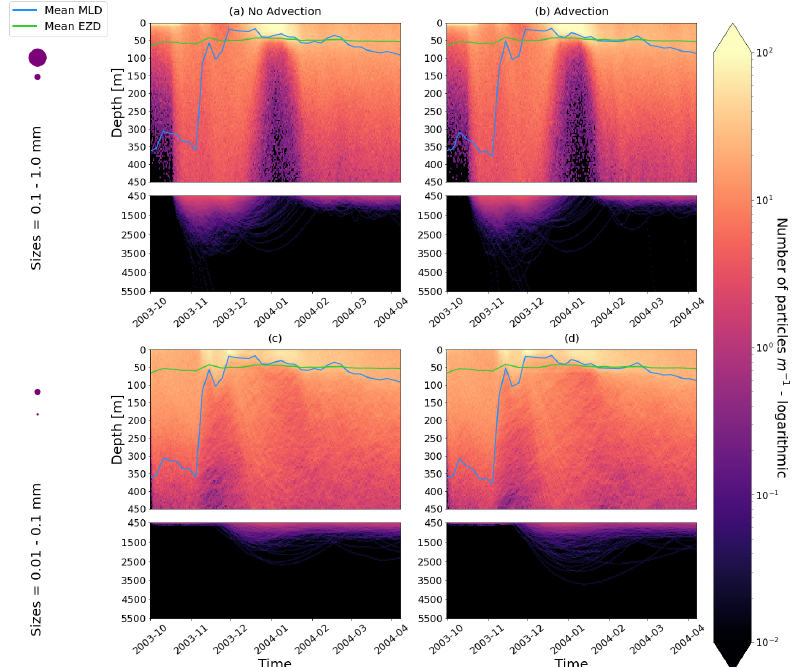
Figure E4. As in Fig. E2 but for particles only in the SO. This means that (a) and (c) are identical to Fig. 2c and f, however, including the 3-month spin-up time and running for fewer days (not a full year).